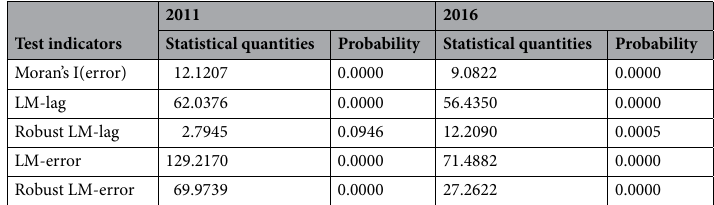
Table 3. Model spatial correlation test results.